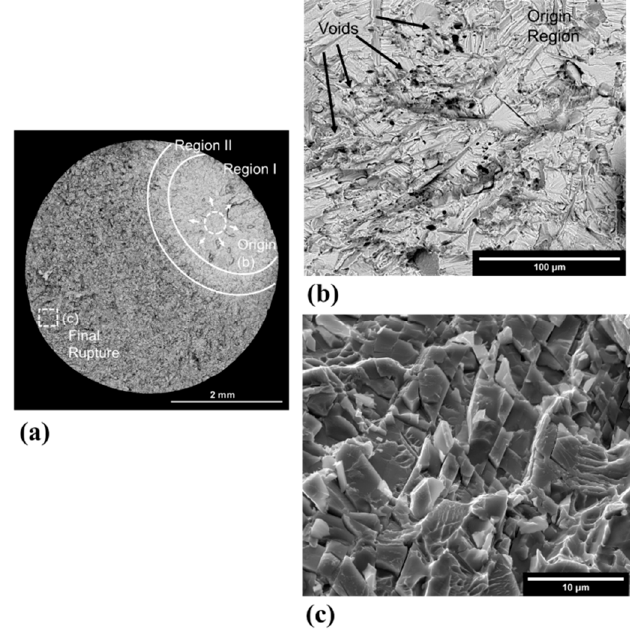
Figure 15. ( a ) BSE-SEM image highlighting the overall fracture surface of a shot-peened PTA-SFFF Ti–TiB fatigue sample, which was tested at a stress amplitude of 382.5 MPa and failed at 506,700 cycles. ( b ) BSE-SEM image highlighting the fatigue crack origin area, taken from the enclosed area in Region I highlighted in ( a ). ( c ) SE-SEM image showing a cross-hatched, cracked fracture surface, taken from the enclosed area in the Final Rupture region highlighted in ( a ).